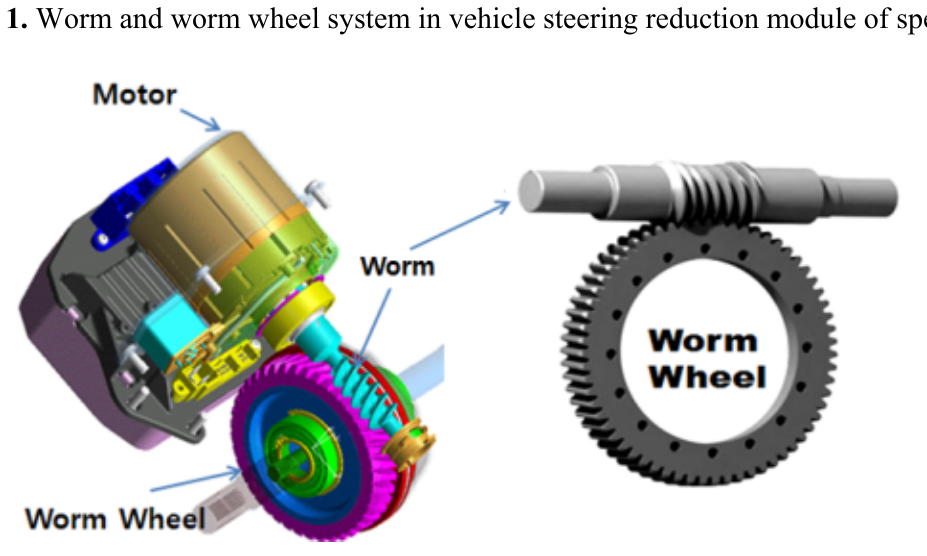
Figure 1. Worm and worm wheel system in vehicle steering reduction module of